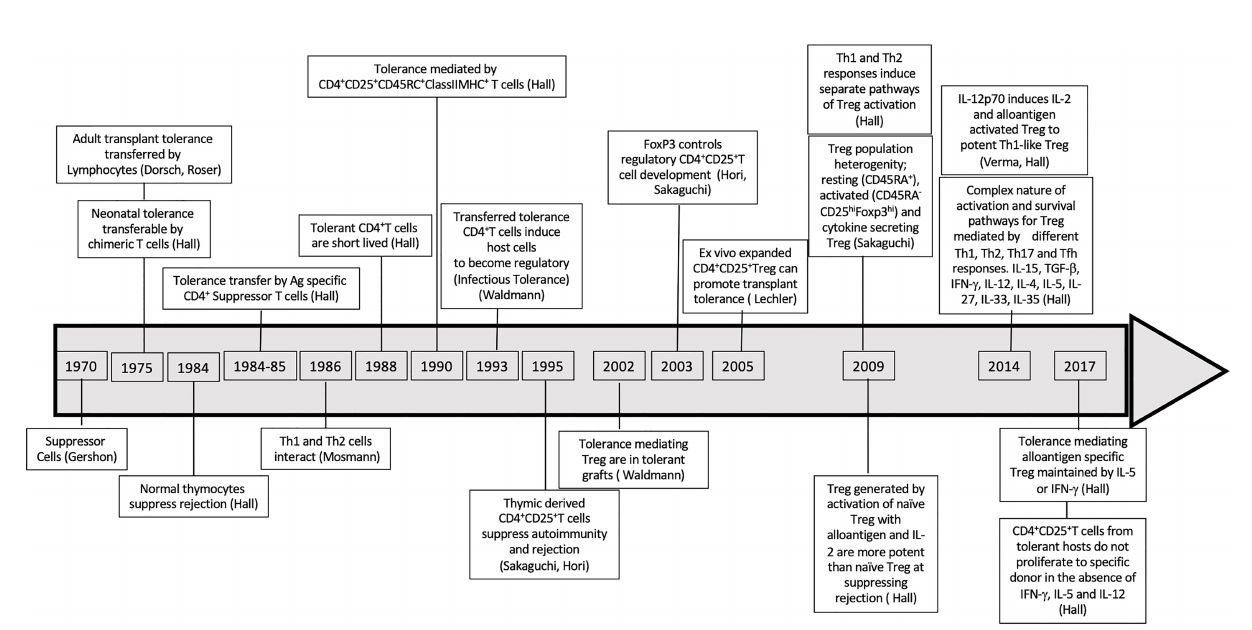
FIGURE 2 | Discoveries Timeline related to suppressor regulatory T cells. Timeline of major discoveries that led to recognition of role of T regulatory cells in tolerance specially in antigen speci fi c